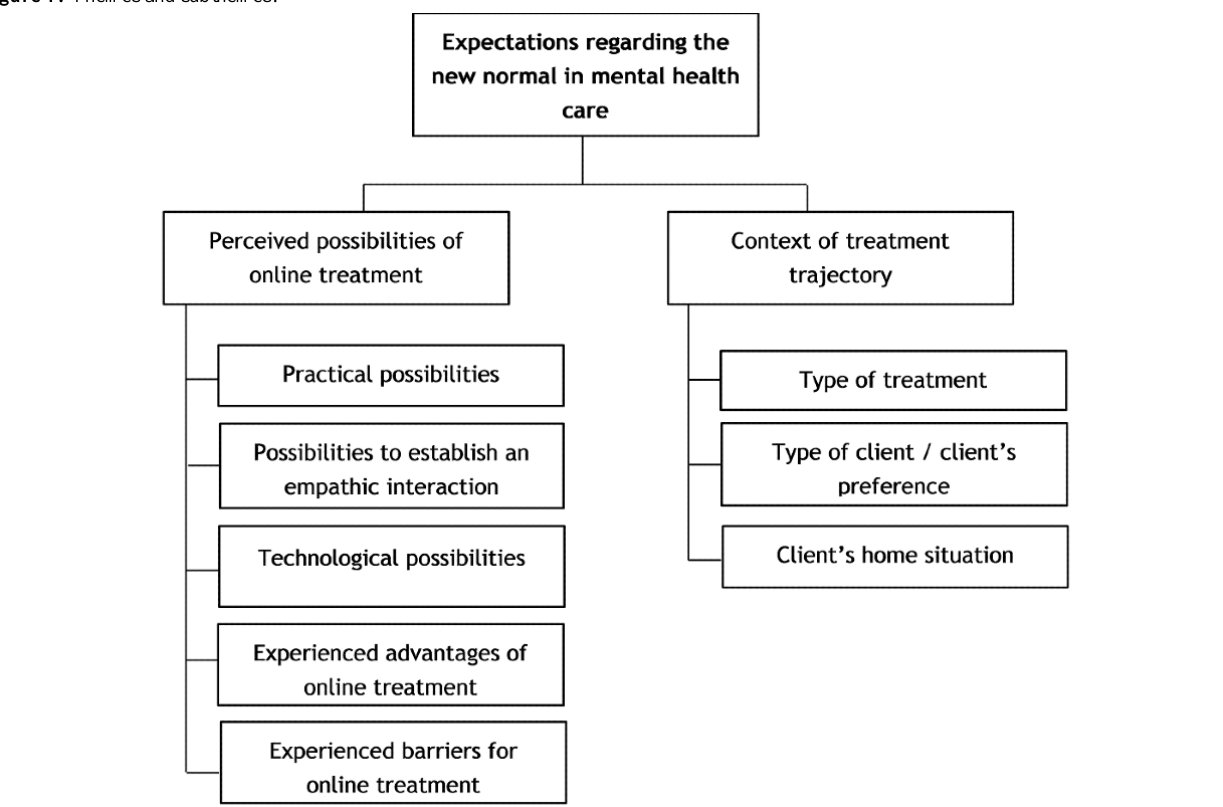
Figure 1. Themes and